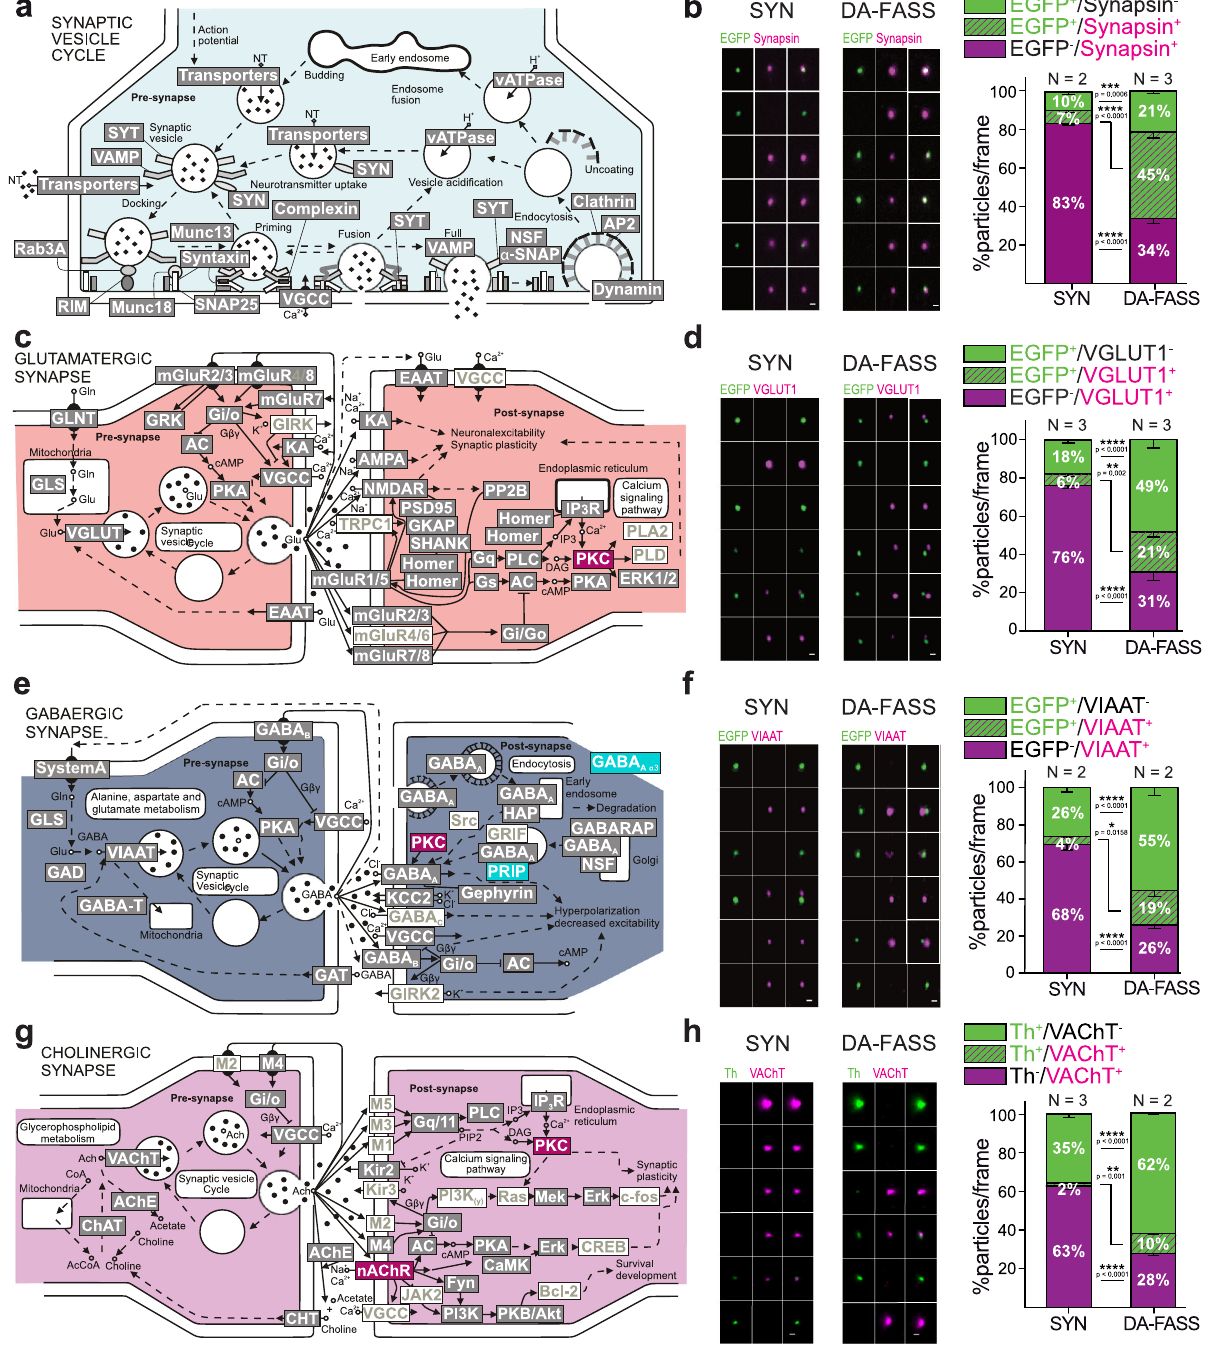
Fig. 5 Proteomics and immuno fl uorescence of DA-FASS sample reveals dopamine synapse association with other synaptic partners. a Scheme of the molecular organization of the synaptic vesicle cycle, c glutamatergic, e GABAergic and g cholinergic synapses (Adapted from the database KEGG). Proteins enriched in DA-FASS samples are in red, depleted in cyan, retained in grey, and absent in white. Gene names for each protein can be found in Supplementary table 4 (ST4). b, d, f, h Epi fl uorescence images of a representative sample of synaptosome populations before and after sorting labelled with anti-EGFP or anti-Th (green) and b anti-Synapsin, d VGLUT1, f VIAAT and h VAChT (magenta). Quanti fi cation of stainings showing particle proportions per frame. All data are mean ± SEM and pulled from N = 2 to N = 3 independent sorts and n = 4 to n = 11 fi eld of view per independent sort. Each independent sort pooled at least 3 animals. b EGFP/Synapsin: Interaction F 2,51 = 237,8 **** p < 0.0001, Condition F 1,51 = 0.01 p = 0.92, Immunolabelling F 2,51 = 237.5 **** p < 0.0001. d EGFP/VGLUT1 Interaction F 2,63 = 91.49 **** p < 0.0001, Condition F 1,63 = 0.002 p = 0.97, Immunolabelling F 2,63 = 92.06 **** p < 0.0001. f EGFP/VIAAT: Interaction F 2 , 78 = 54.90 **** p < 0.0001, Condition F 1,78 = 0.04 p = 0.844, Immunolabelling F 2,78 = 55.34 **** p < 0.0001. h Th/VAChT Interaction F 2,144 = 180.3 **** p < 0.0001, Condition F 1,144 = 0.016 p = 0.9, Immunolabelling F 2,144 = 412.2 **** p < 0.0001 with Š ídák ’ s multiple comparisons test. For all panels, scale bar = 1 μ m. See VGLUT2 immuno fl uorescence analysis in Supplementary Fig. 4.